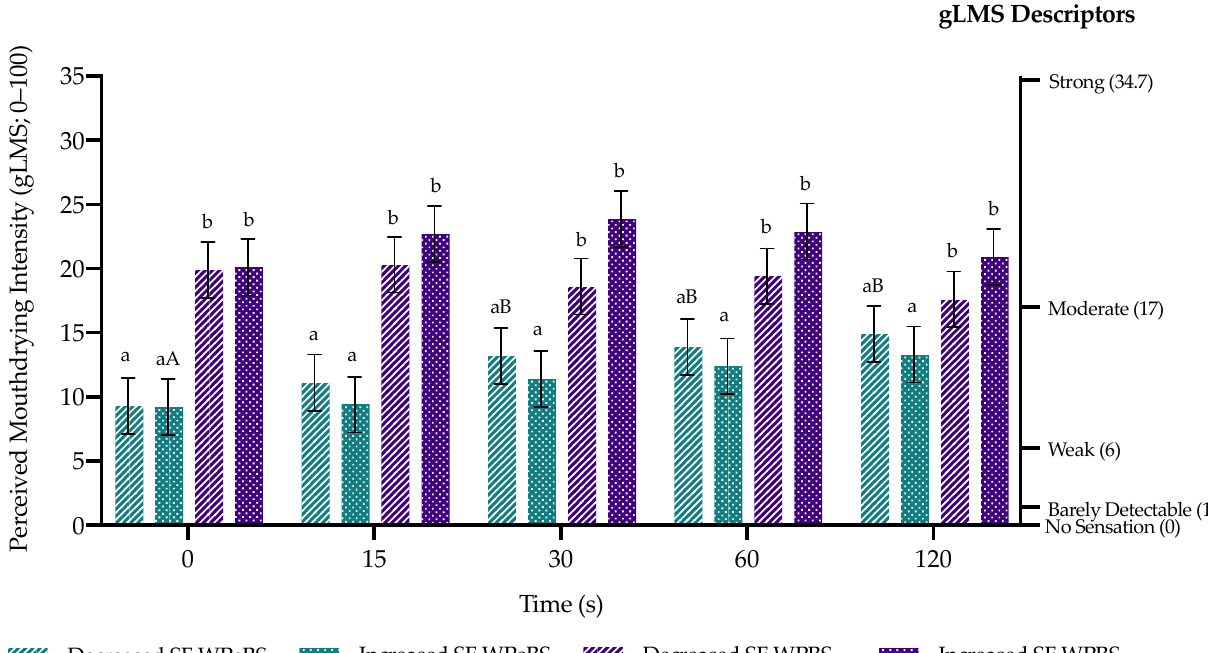
Figure 6. Volunteers’ perceived mouthdrying ( ± standard error) post beverage (WPeBS: whey permeate beverage sweetened;